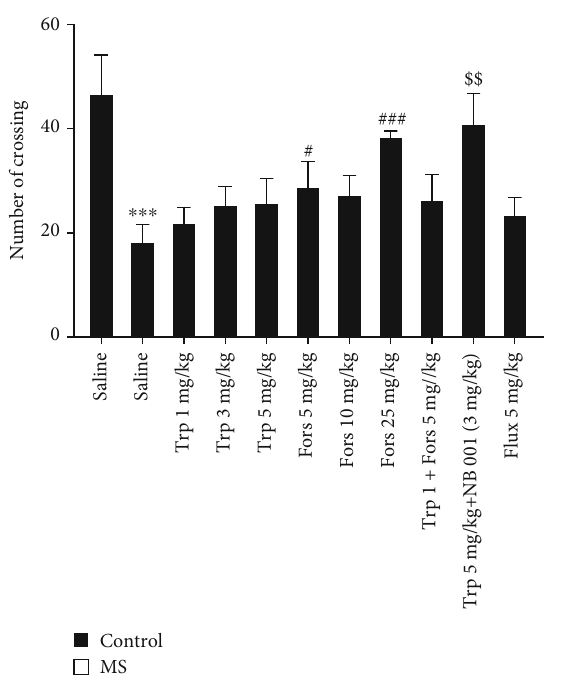
Figure 2: Immobility time in the FST. Values are presented as the mean ± S : E : M : from 6 animals and were analysed using one-way ANOVA followed by Tukey ’ s post test. Drugs were dissolved in physiological saline and injected as a single dose via intraperitoneal (i.p.) route with a volume of 5ml/kg body weight one hour before the test. ∗∗∗ P < 0 : 001 compared with the saline-treated control group, ### P < 0 : 001 compared with the saline-treated MS group, and &&& P < 0 : 001 compared with the tropisetron-